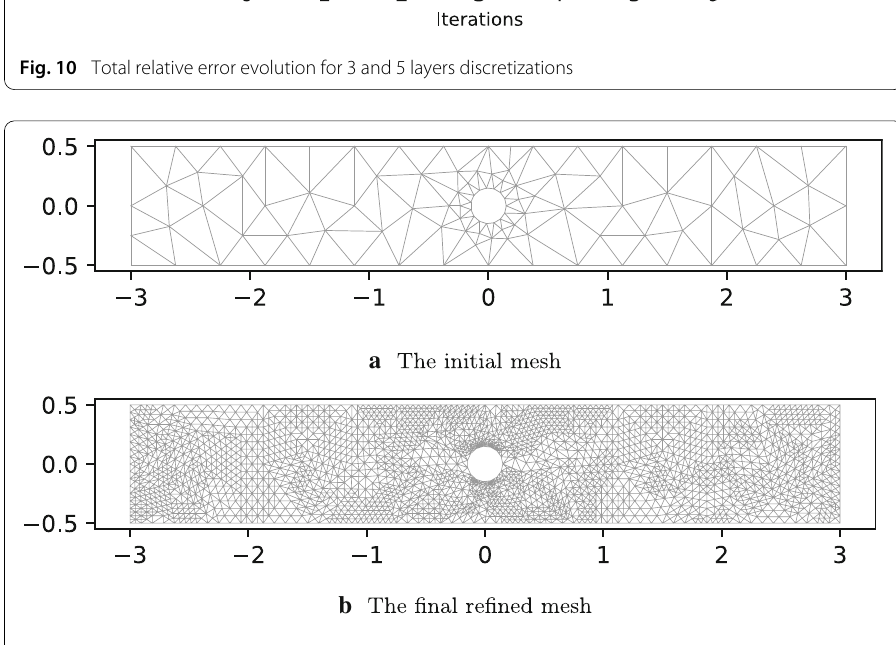
Fig. 11 Mesh refinement for the plate with a circular hole